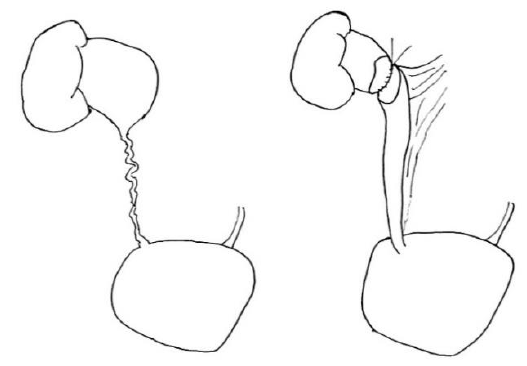
Figure 1: PUJ. Use of appendix to replace